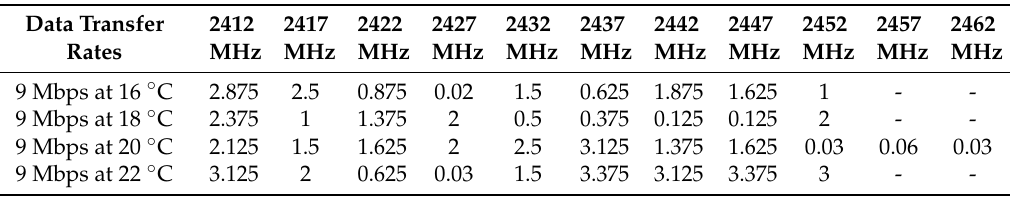
Table 12. Calculation of residuals for OFDM at 9 Mbps.